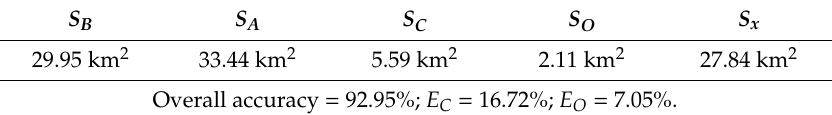
Figure 4. Maps of pen aquaculture created by using the method proposed in this study ( a ), visual interpretation method ( b ) and comparison of these two maps ( c ). A1: Area in agreement; A2: Omission area (i.e., the aquaculture area identified as non-aquaculture area); A3: Commission area (i.e., the non-aquaculture area identified as aquaculture area). Table 1. Accuracy assessment of the pen aquaculture area extracted.